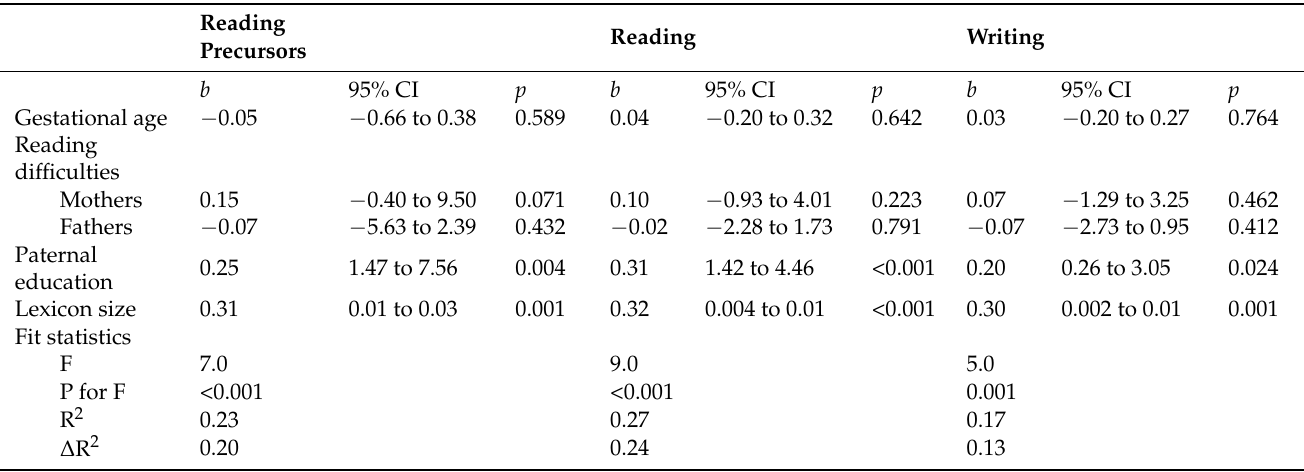
Table 5. Results of multiple variable linear regression analysis with reading precursors, reading and writing skills at 7 years of age as dependent variables, and with lexicon size at 2 years of corrected age and background factors as independent variables. Results of VP/VLBW children are presented.